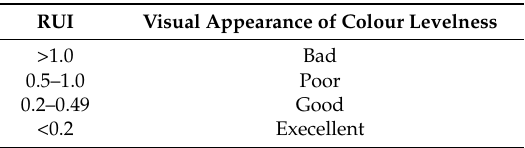
Table 3. Interpretation of relative unlevelness index (RUI) values. Reproduced with permission from reference [21], Copyright John Wiley and Sons,